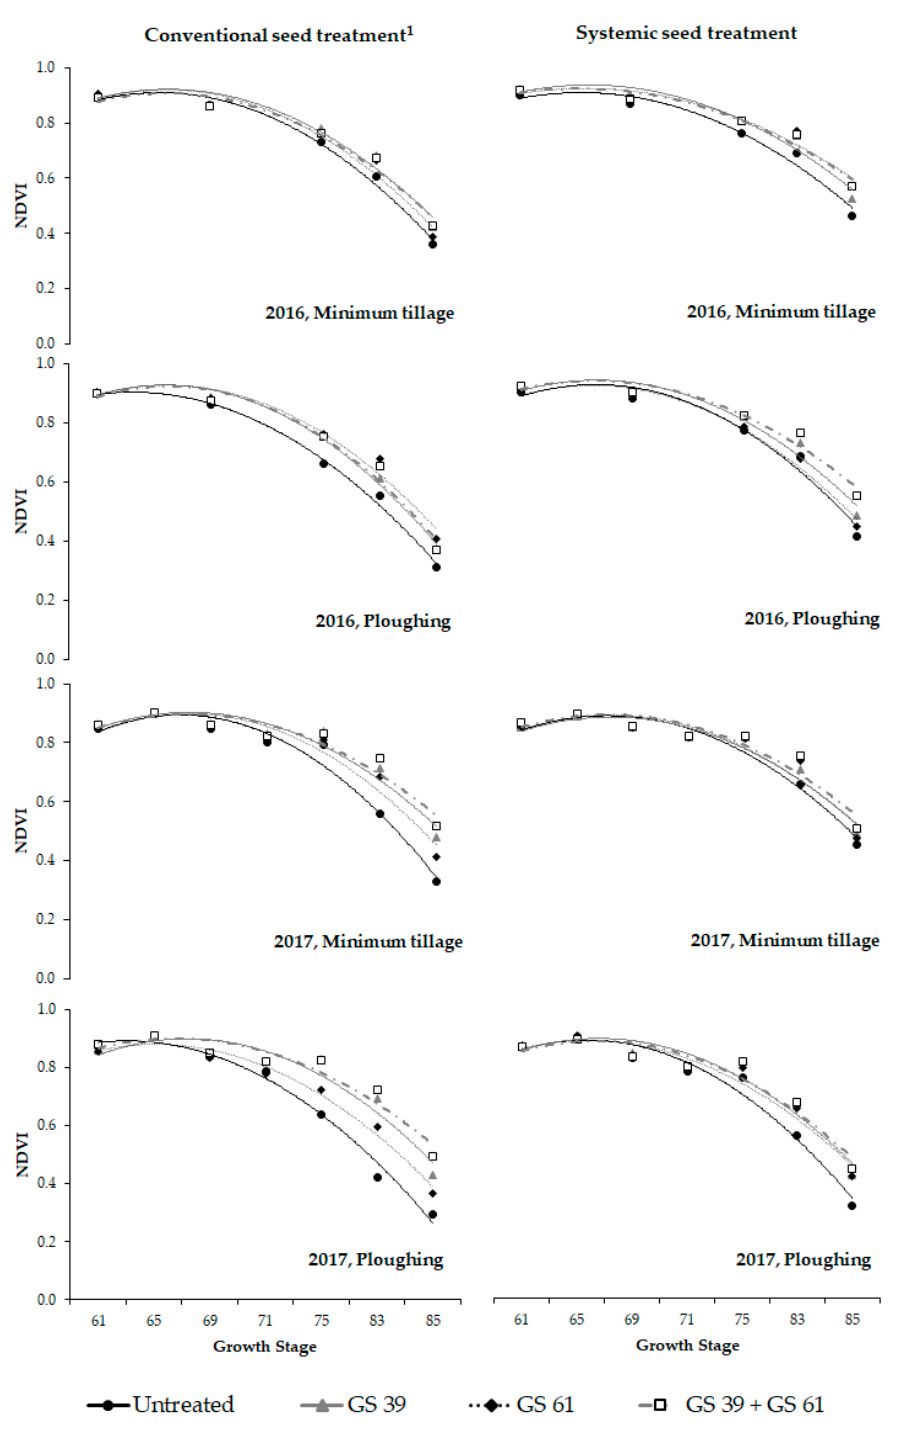
Figure 3. Effect of the fungicide foliar treatments 2 on the normalized difference vegetation index (NDVI) measured from anthesis (GS61) until the soft dough stage (GS85), considering the seed treatments, soil tillage, and growing seasons (2015–2016 and 2016–2017). The reported values are based on four replications. 1 Fungicide seed treatments: conventional (fludioxonil AI) and systemic (fluxapyroxad AI); 2 Fungicide foliar treatment: untreated control; GS39, a single treatment at the end of stem elongation (pyraclostrobin + fluxapyroxad AI); GS61, a single treatment at the beginning of flowering (epossiconazole + metconazole AI); GS39 + GS61, a double treatment through a combination of the GS39 and GS61 applications.